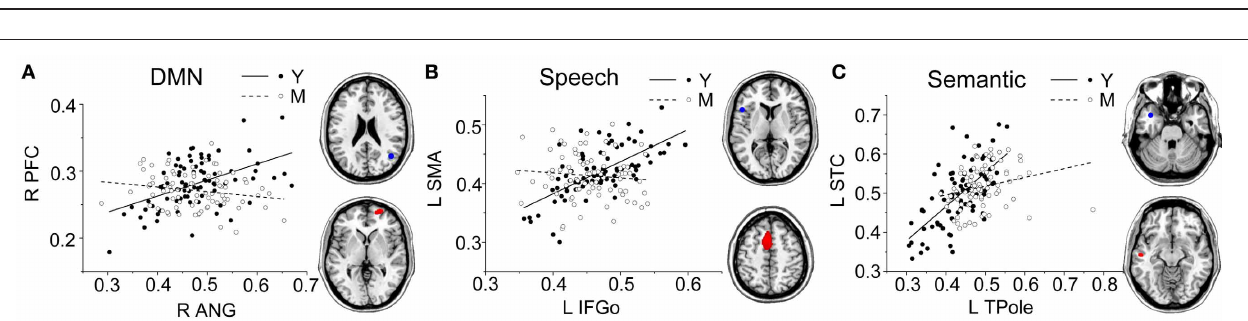
FIGURE 3 | Age-related changes in salience, executive control, and default-mode structural covariance networks. (A) Statistical maps of regions significantly correlated with the seed region in each group. The results are presented as correlation coefficient values ( P < 0 . 05, FWE corrected). (B) The plots of voxel counts by group indicate abrupt contraction